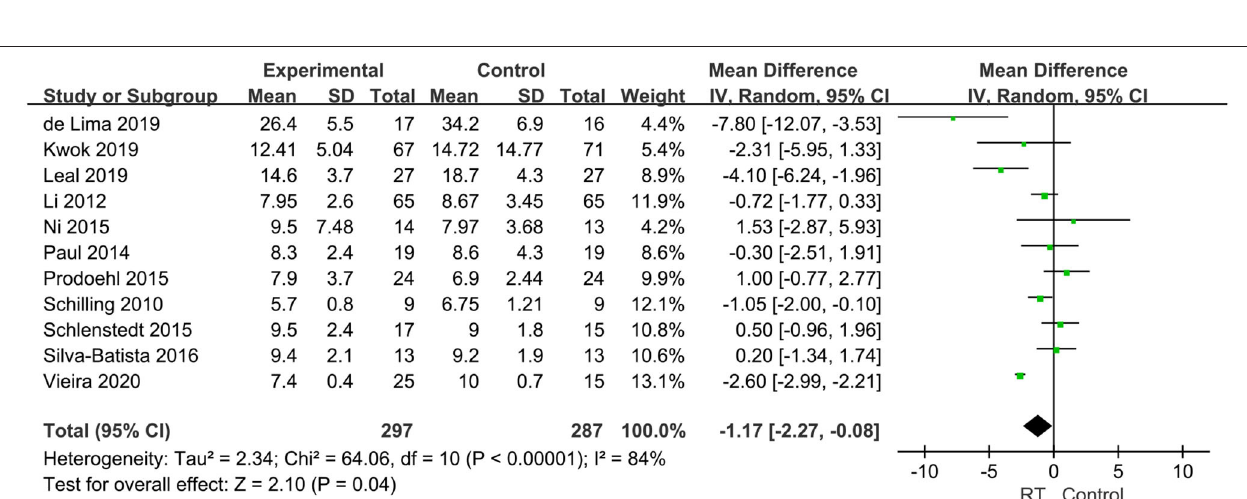
FIGURE 6 | Forest plots of the effects of lower limb RT on gait performance—fast gait velocity in PD. CI, confidence interval.